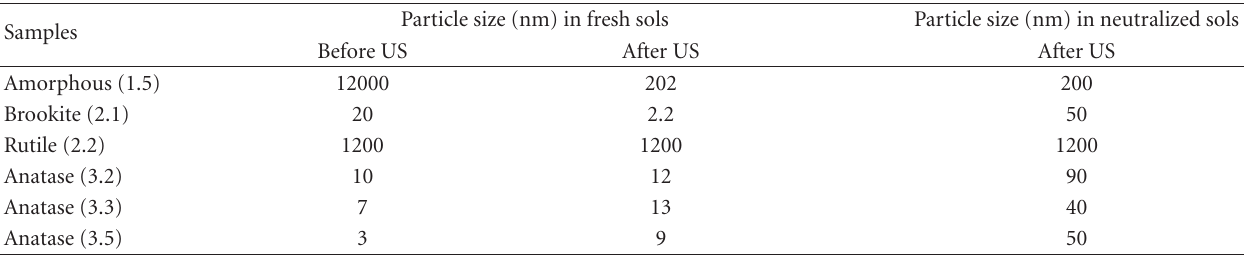
Table 2: Hydrodynamic diameters of TiO 2 particles in freshly prepared and neutralized sols.